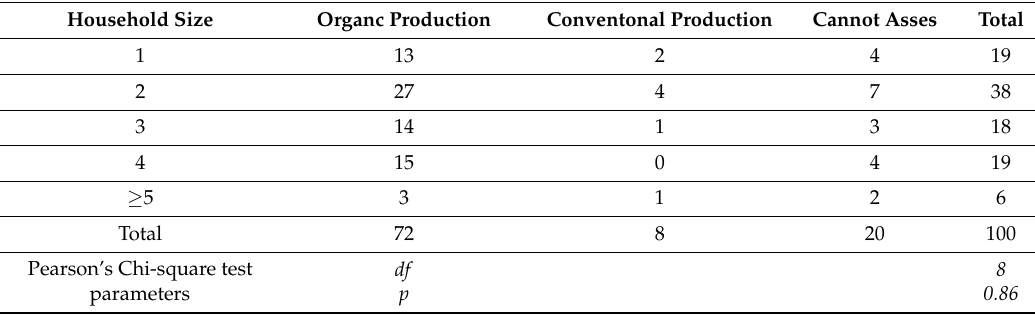
Table 7. Relation between household size and sustainable farming